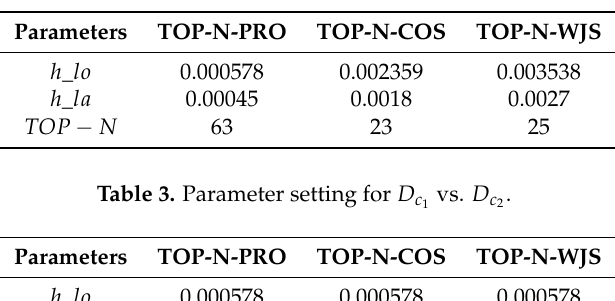
Table 2. Parameter Setting for D g